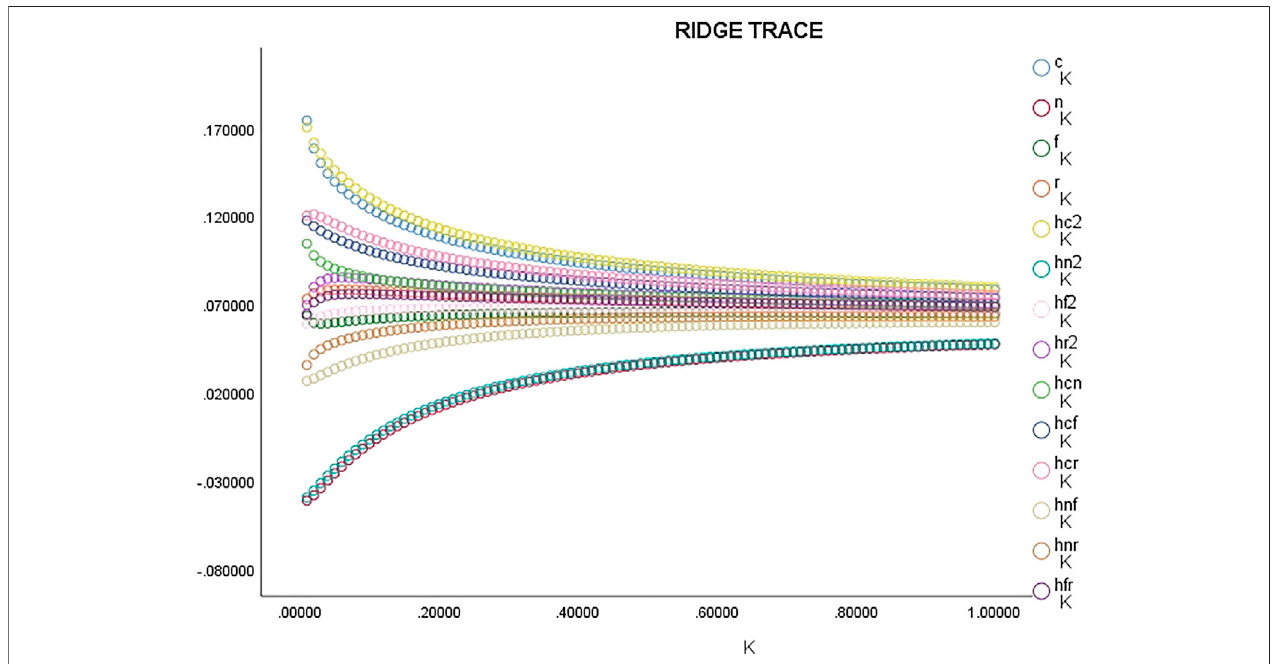
FIGURE 2 | Ridge trace